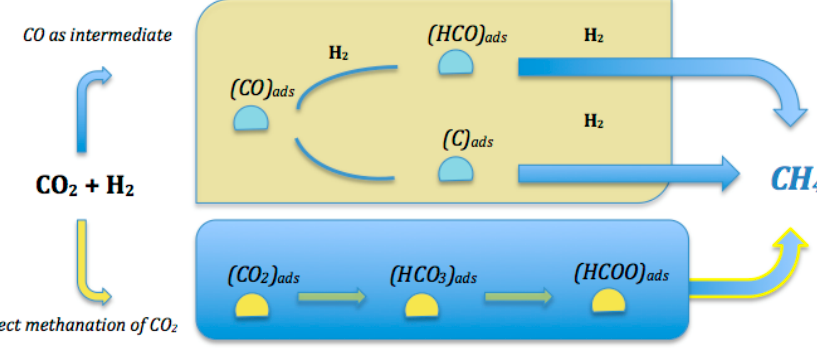
Figure 2. Simplified reaction mechanisms of CO 2 methanation.